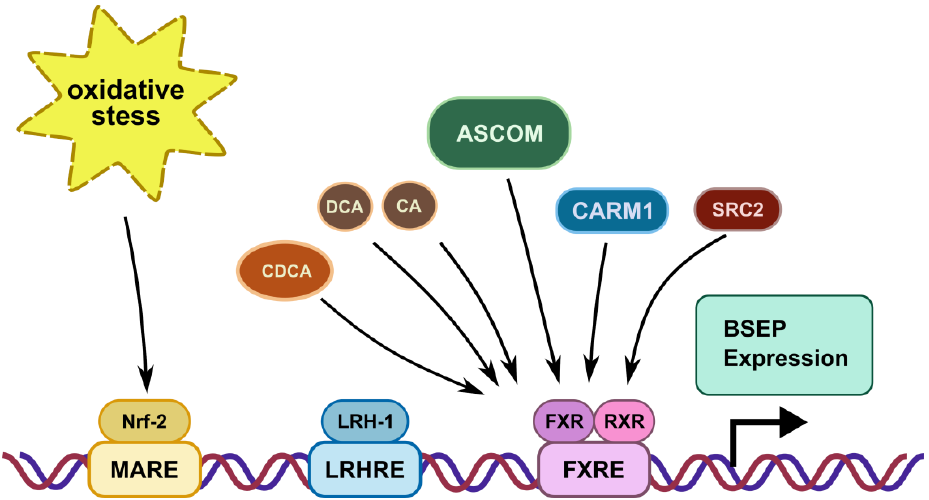
Figure 2. Transcriptional regulation of BSEP via recognition sequences in the promoter region of the BSEP gene: MARE: Maf recognition element; LRHRE: liver receptor homolog-1 responsive element; FXRE: farnesoid X receptor responsive element. The farnesoid receptor FXR binds bile salts after heterodimerization with the retinoid X receptor. The ligand with the highest affinity for FXR is chenodeoxycholic acid (CDCA): however deoxycholic (DCA) and cholic acid (CA) also increase BSEP expression. The co-activators ‘activating signal cointegrator-2-containing complex’ (ASCOM), ‘co-activator-associated arginine methyltransferase 1’ (CARM1) and ‘steroid receptor co-activator SRC2’ (SRC2) increase BSEP expression via FXR. Liver receptor homolog 1 (LHR-1) and nuclear factor erythroid 2-related factor (Nrf-2), a sensor for oxidative stress, also increase BSEP